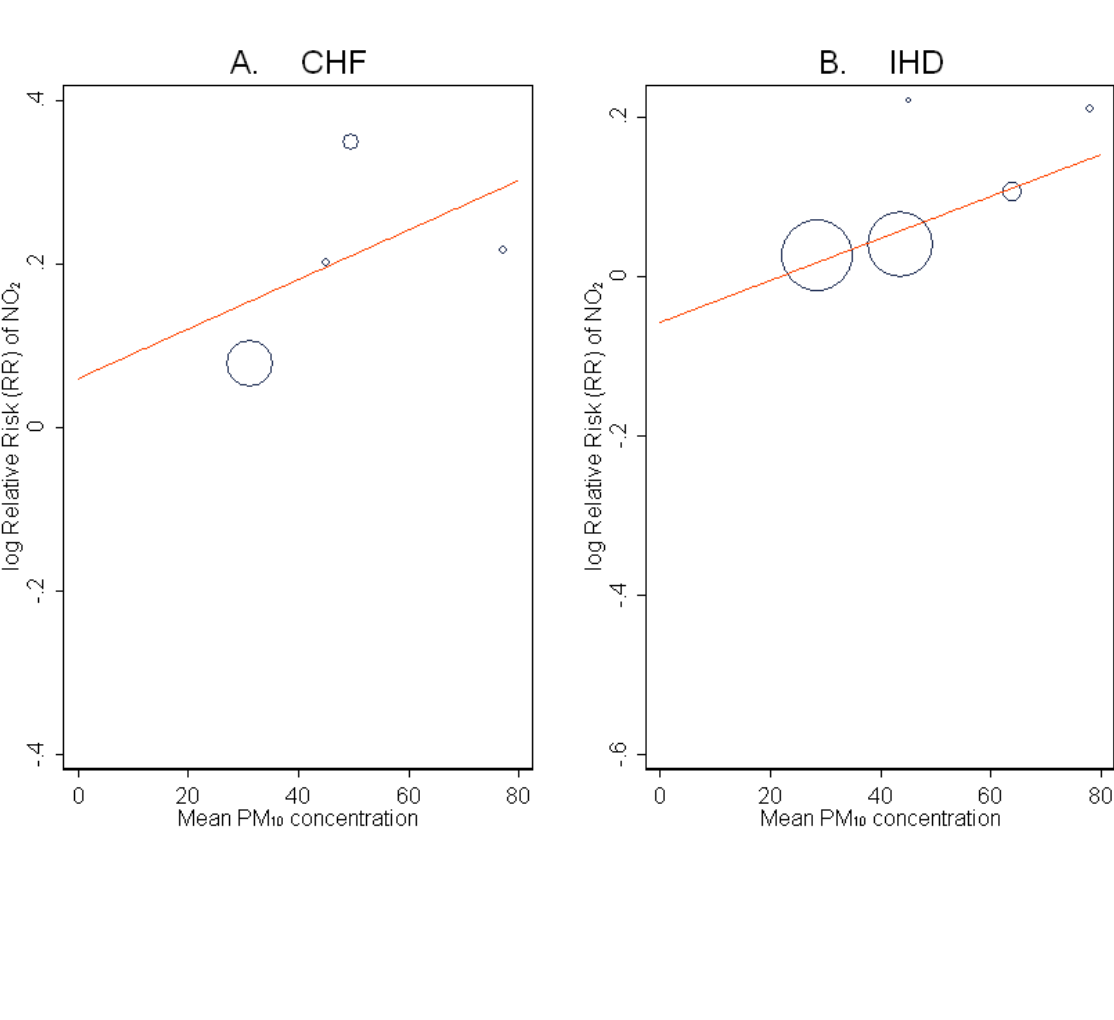
Figure 3. Univariate relationships between the log Relative Risk (RR) of hospitalization for ( A ) congestive Heart Failure (CHF) and ( B ) Ischemic Heart Disease (IHD) in association with NO and, mean PM 2 10